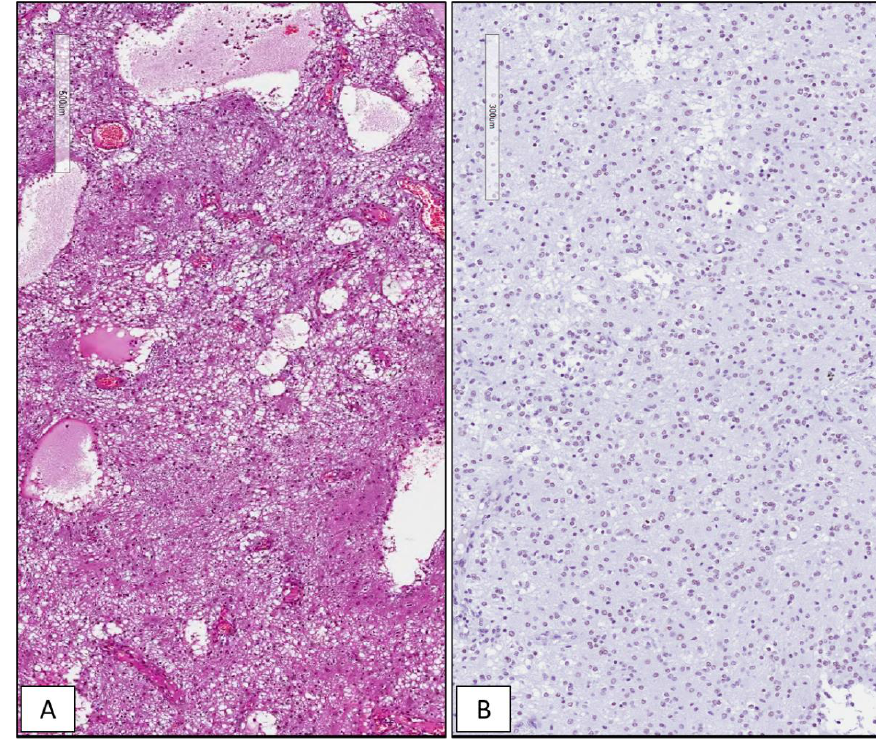
Figure 4. WHO grade I pilocytic astrocytoma. Histopathological examination showing the typical biphasic appearance consisting of compacted bipolar cells with Rosenthal fibers and multipolar cells embedded in a loose, myxoid and/or microcystic background ( A ); weak and focal nuclear immunohistochemical expression of SRSF1 in WHO grade I pilocytic astrocytoma ( B ) (hematoxylin and eosin ( A ) and immunoperoxidase ( B ) staining; original magnifications 100×).